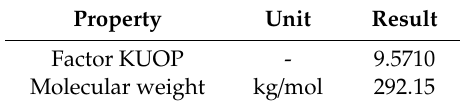
Table 18. Properties of heavy crude calculating from experimental